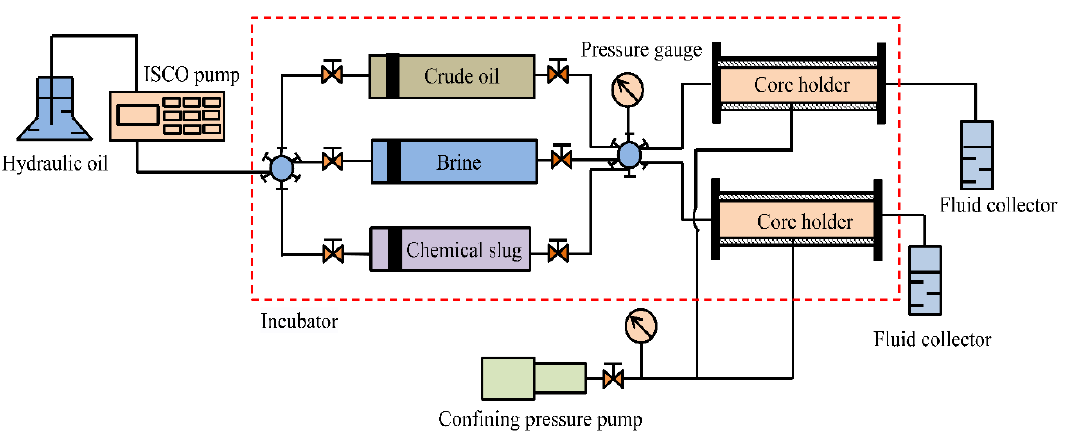
Figure 2. Schematic of the experimental set-up. The experimental set-up consisted of two hydrostatic core holders, a pump to maintain confining pressure, a displacement pump for the flooding agent, and two fluid accumulators for holding the collected oil sample, brine, and chemical slug.